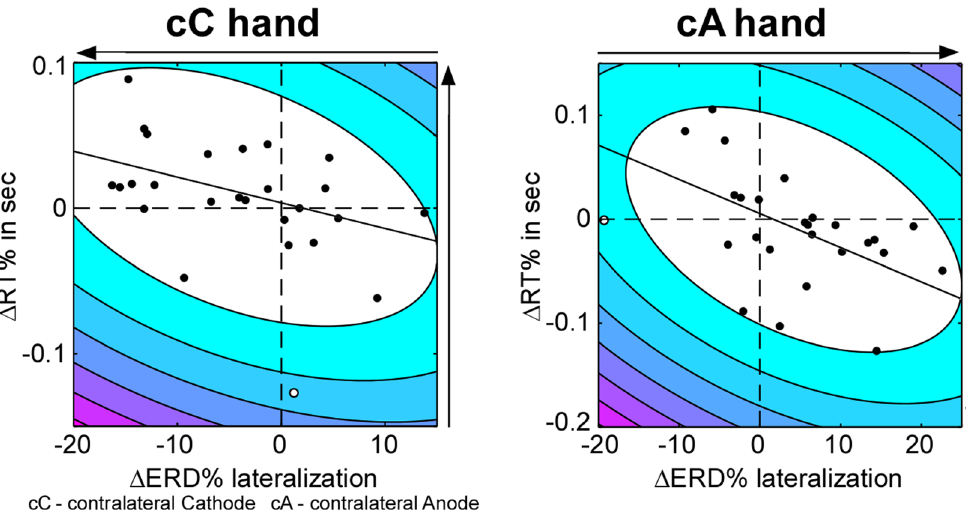
Figure 5. Association between Δ ERD% lateralization and Δ RT% for the hand contralateral to the cathode (left half) and for the hand contralateral to the anode (right half). Contour lines represent the bootstrapped Mahalanobis distance from the bivariate mean in steps of six squared units (purple colours indicate greater distance). White circles represent outliers. The horizontal dashed lines mark zero and the solid line is the linear regression over the data after outlier removal. Direction of the arrows indicates the expected stimulation-related